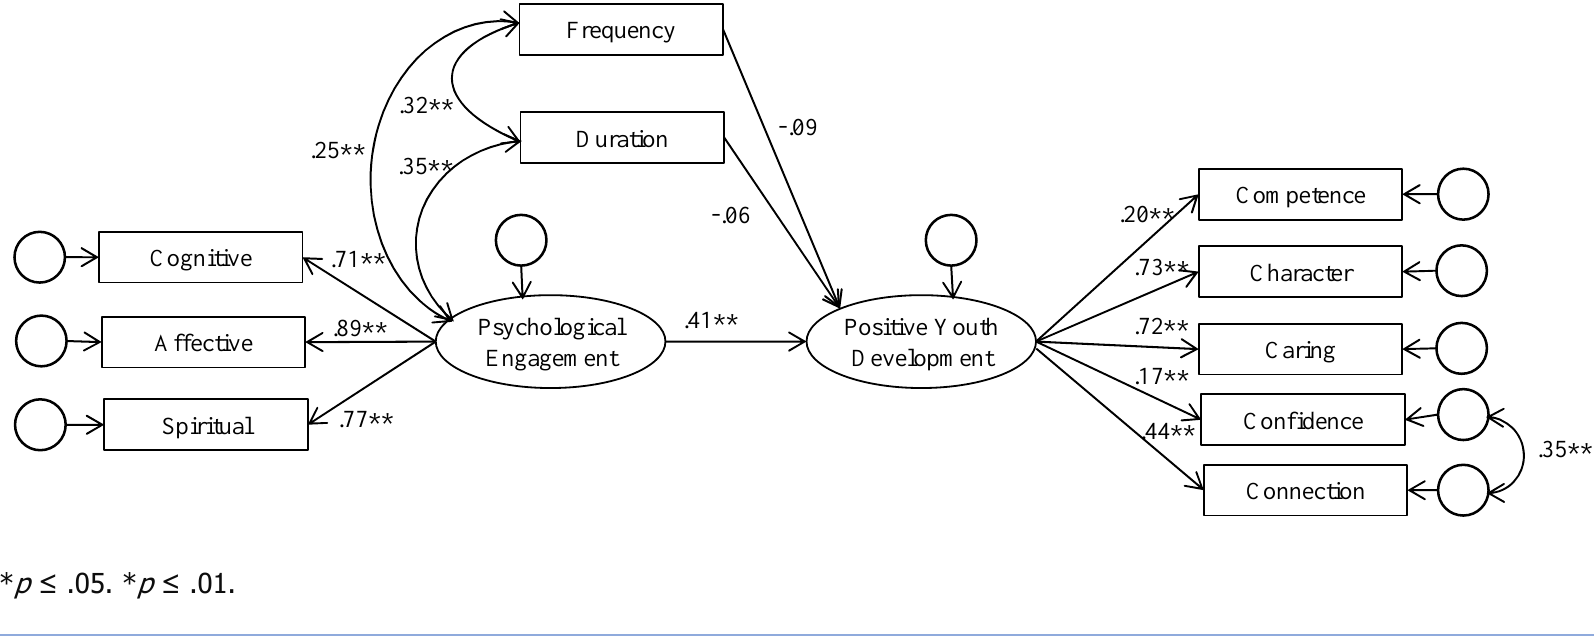
Figure 1. SEM Model of Psychological Engagement and Behavioral Participation Predicting Positive Youth Development